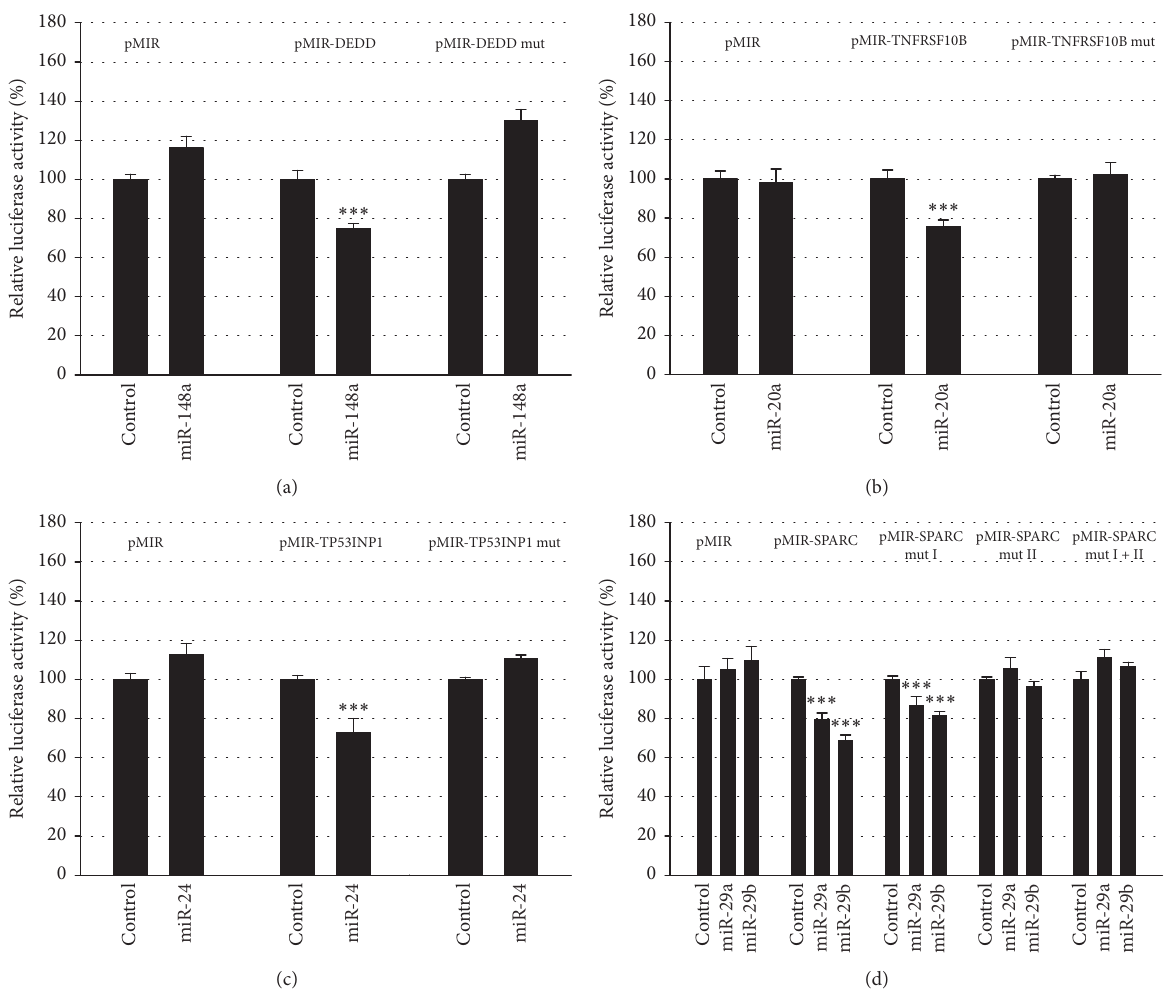
Figure 4: Identification of miRNA binding sites. The potential binding sites for the indicated miRNAs in the 3 󸀠 UTRs of DEDD (a), TNFRSF10B (b), TP53INP1 (c), and SPARC (d) were mutated by site directed mutagenesis (mut) and coexpressed with the miRNA expression construct or with the empty pSG5 vector in the indicated combinations. Results represent the mean of 4 independent experiments performed in duplicate. ∗∗∗ 𝑝 < 0.001